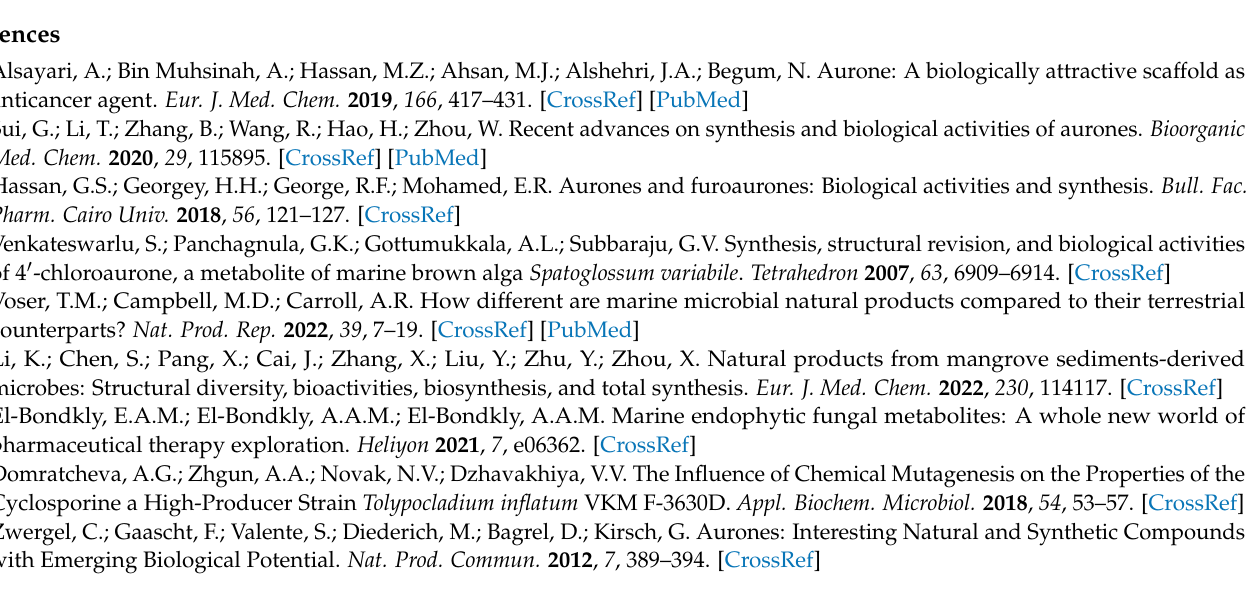
active compound; Figure S2: 13C NMR spectrum of the active compound; Figure S3: DEPT135 spectrum of the active compound; Figure S4: DEPT90 spectrum of the active compound; Figure